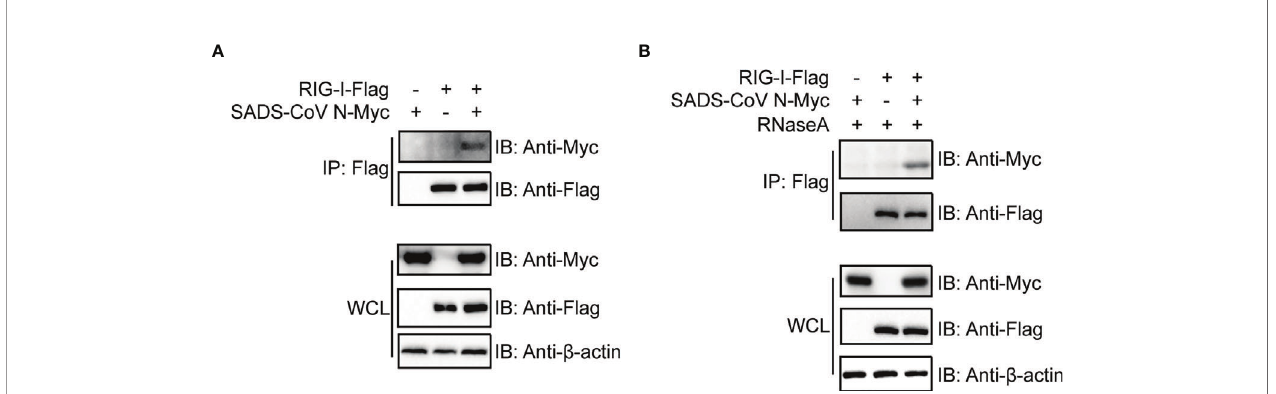
FIGURE 4 | The SADS-CoV N protein binds to RIG-I in a manner independent of RNA. Myc-tagged SADS-CoV N protein and fl ag-tagged full length RIG-I were coexpressed in 293T cells. At 36 h post-transfection, cell lysates were either immunoprecipitated (IP) by antibodies against fl ag-tag directly (A) or treated with 100 m g/ml RNase A on ice for 1 h before IP (B) . SADS-CoV N and RIG-I in IP products and whole cell lysates were detected with western blot using antibodies against myc-tag and fl ag-tag,